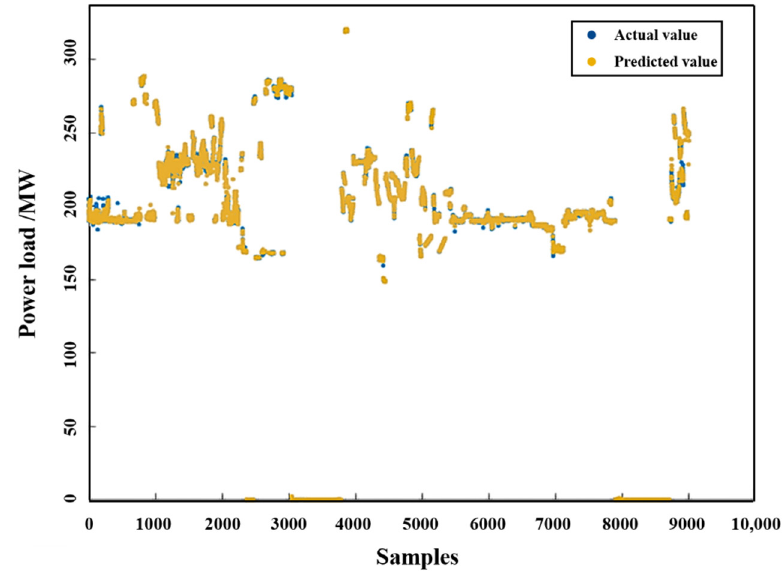
Figure 4. Comparison between the predicted load and actual load.